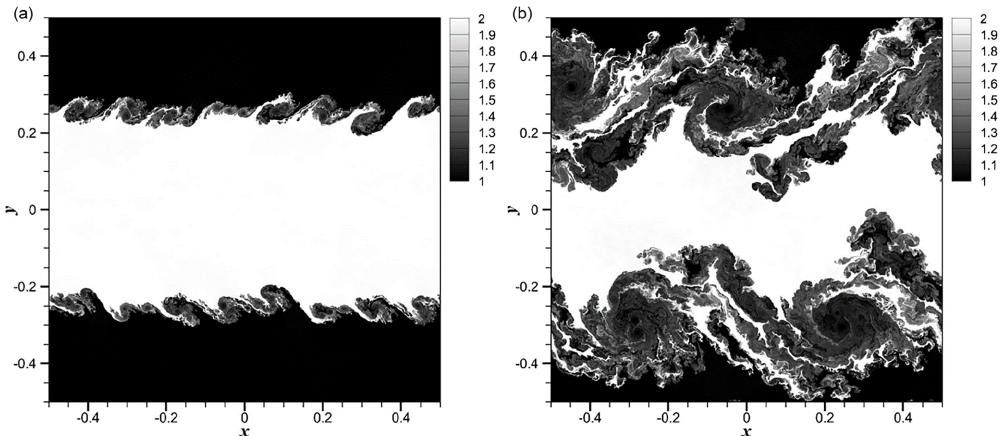
Figure 4. Time evolution of the density field for 2-D KHI turbulence with α = 0 . 25 demonstrating results at t = 1 (a) and t = 5 (b) obtained by a grid resolution of N 2 = 16384 2 .